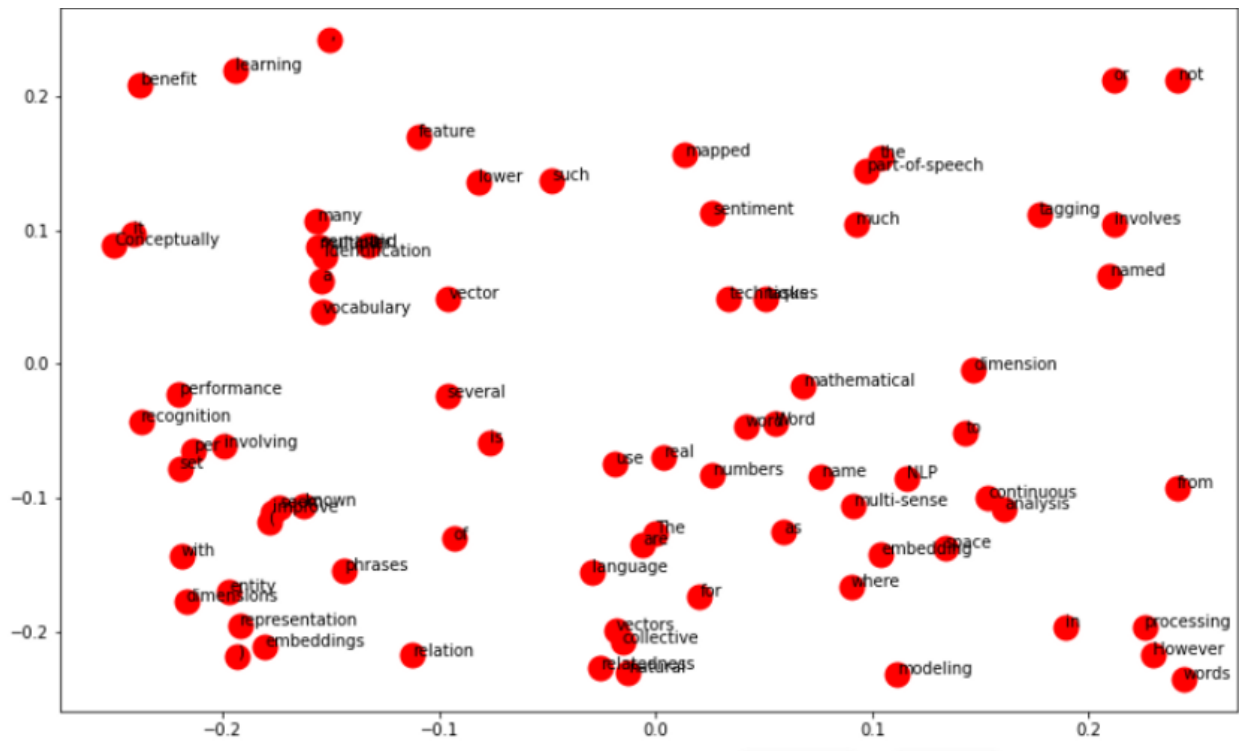
Figure 2. Example of a simple word embedding on a 2D plane, with words taken from the Wikipedia definition of “word embedding” (https://towardsdatascience.com/visualization-of-word-embedding-vectors-using-gensim-and-pca-8f592